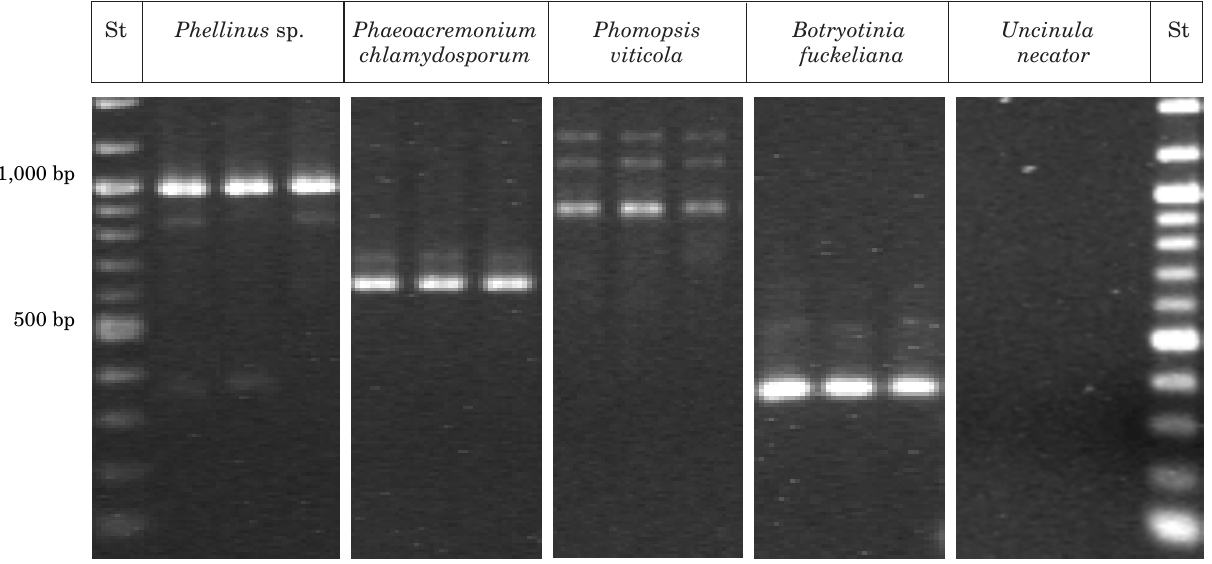
Fig. 3. Example of a PCR-RAPD marker selective for Phellinus sp. not found in other phytopathogenic fungi associ- ated with grapevine. Each line represents a different isolate and all reactions were primed by the same 10-mer